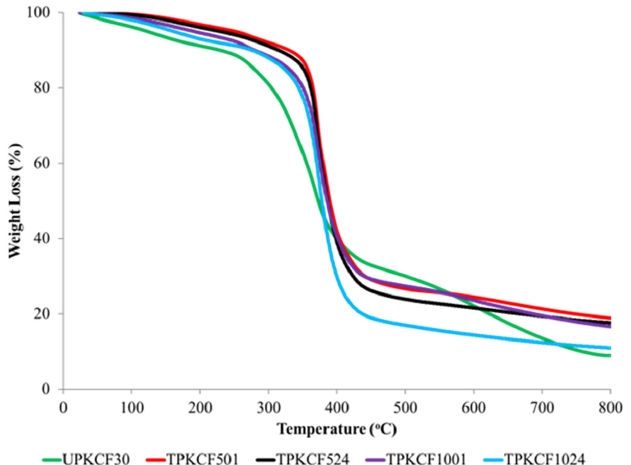
Figure 11. TGA curves of untreated and treated PKCF/ER composites.